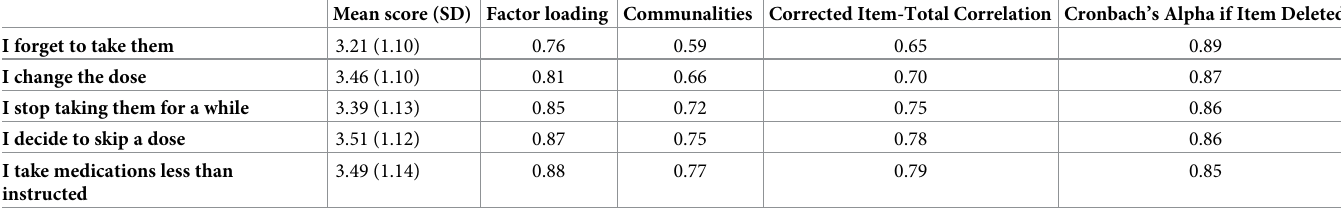
Table 2. Scores, factor loadings, communalities, corrected item total correlation, and Cronbach’s alpha if item deleted for MARS-5